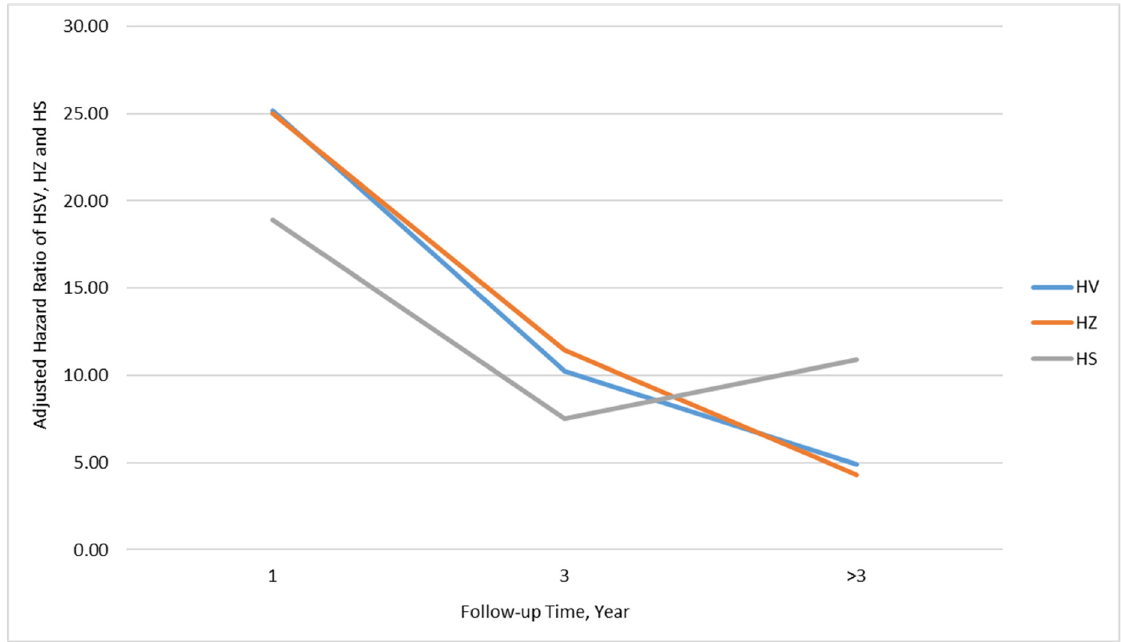
Figure 1. The incidence of developing aHZ in SOT recipients stratified by post-transplant period from an index date within 1 year, between 1 and 3 years, and after more than 3 years.